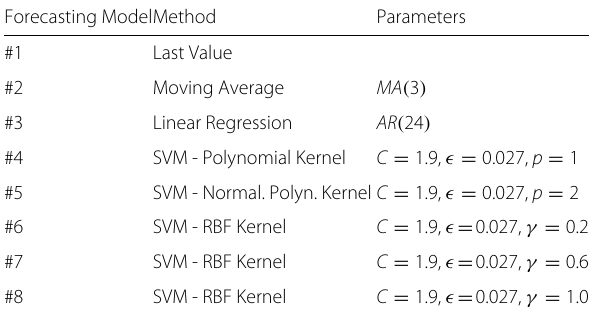
Table 2 Summary of different forecasting